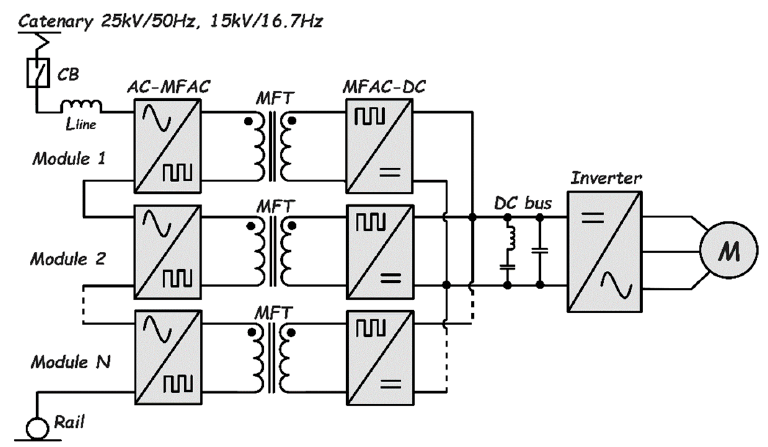
Figure 16. Two-stage cascaded PET.